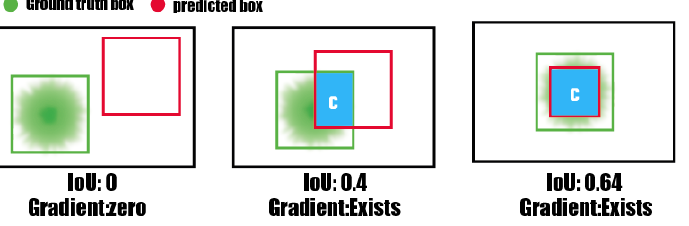
Figure 12. Example of intersection area (IoU). ’C’ represents the Intersection, which is the area of overlap between the ground truth and prediction.